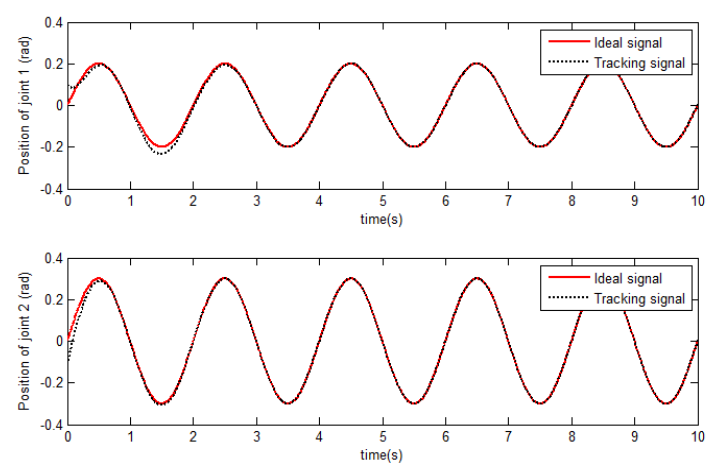
Figure 7. Position of ARA joint 1 and joint 2.